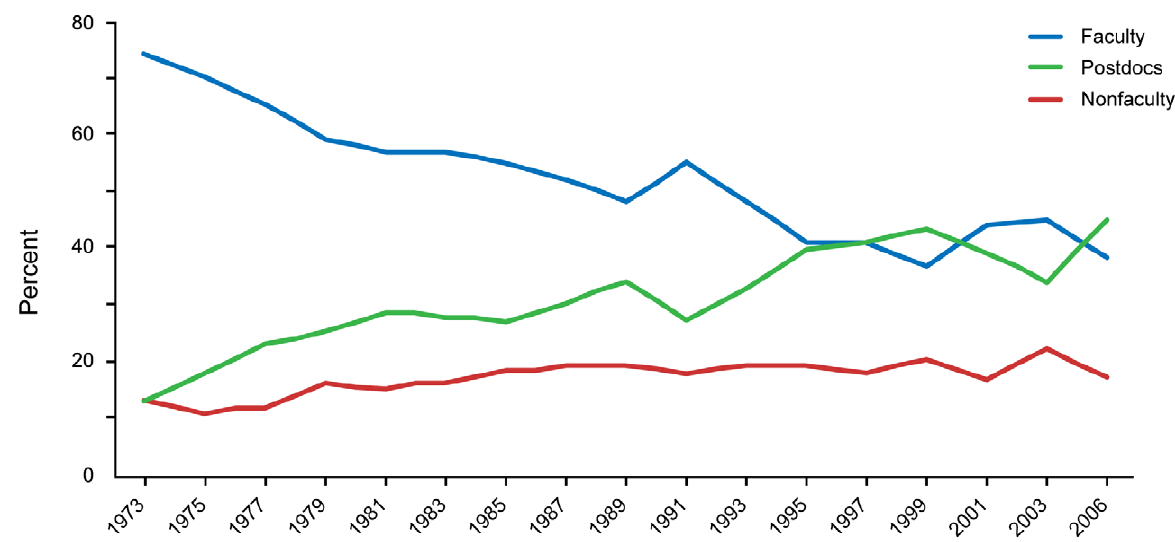
Figure 4. Number of Positions in the Biological Sciences, 1981–2006. The number of full-time faculty (blue) in the biological sciences has decreased between 1981 and 2006, while the number of postdoctoral fellows (green) has increased, and number of nonfaculty full-time positions (red) has remained relatively steady. Faculty included full-time full, associate, and assistant professors plus instructors. Nonfaculty positions included research associates, adjunct appointments, lecturers, and administrative positions. SOURCE: National Science Foundation, Science and Engineering Indicators 2010.